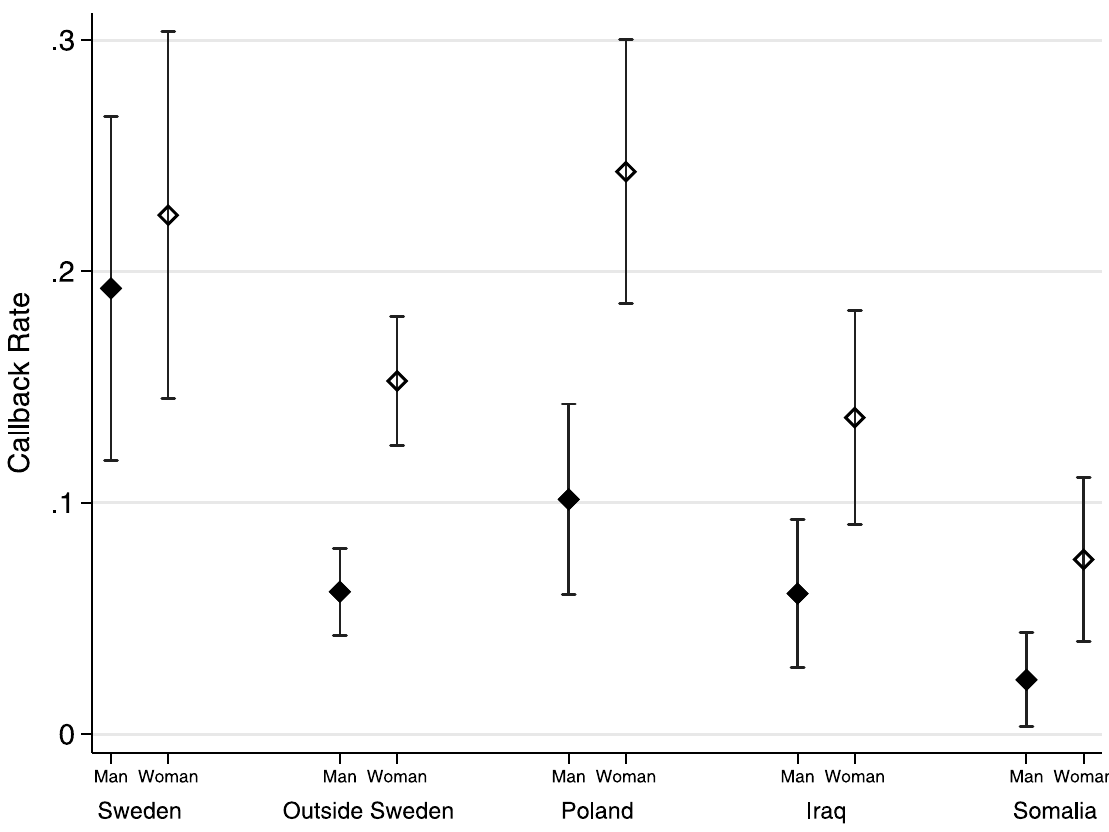
Fig 2. Callback rates by country of birth and gender. Note: Capped bars represent 95% confidence intervals.